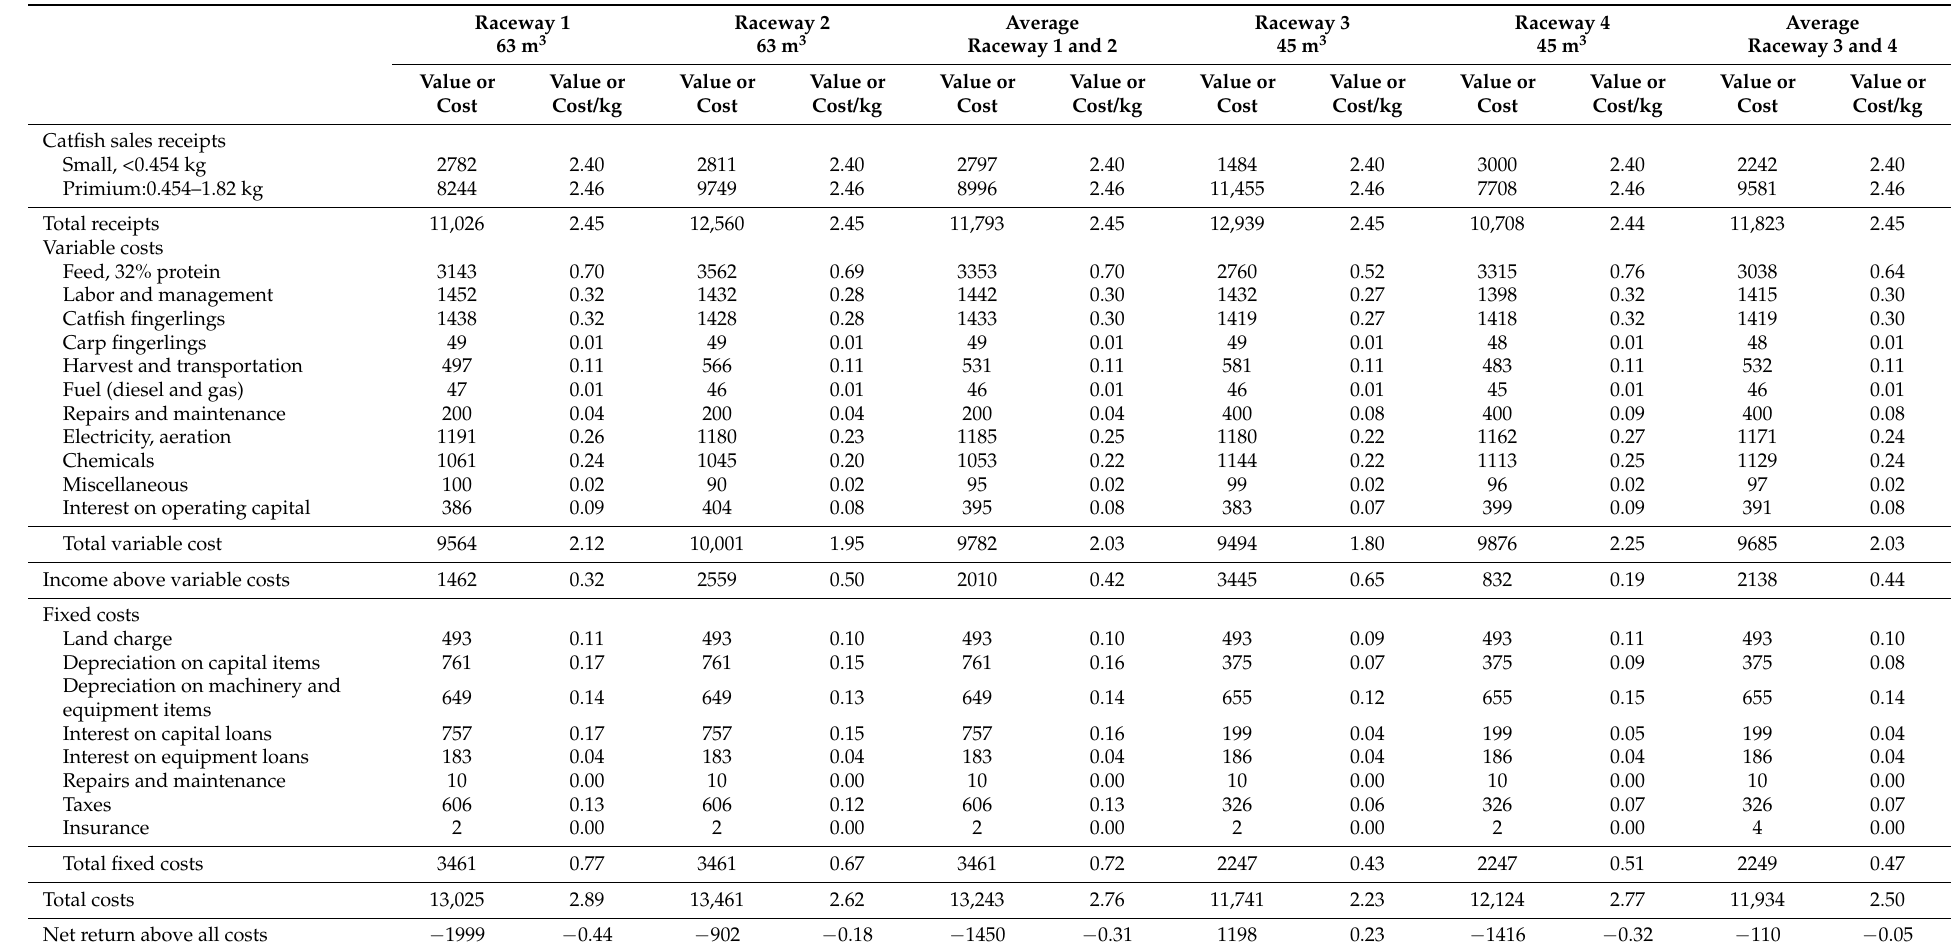
Table 6. Growout enterprise budgets for four in-pond raceway system (IPRS) producing foodsize hybrid catfish, channel catfish Ictalurus punctatus I. furcatus , with each raceway placed in a 0.4 ha pond, USD, ♂